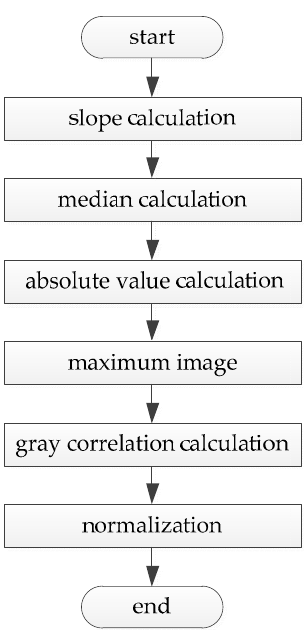
Figure 2. Flow char of model optimization method.